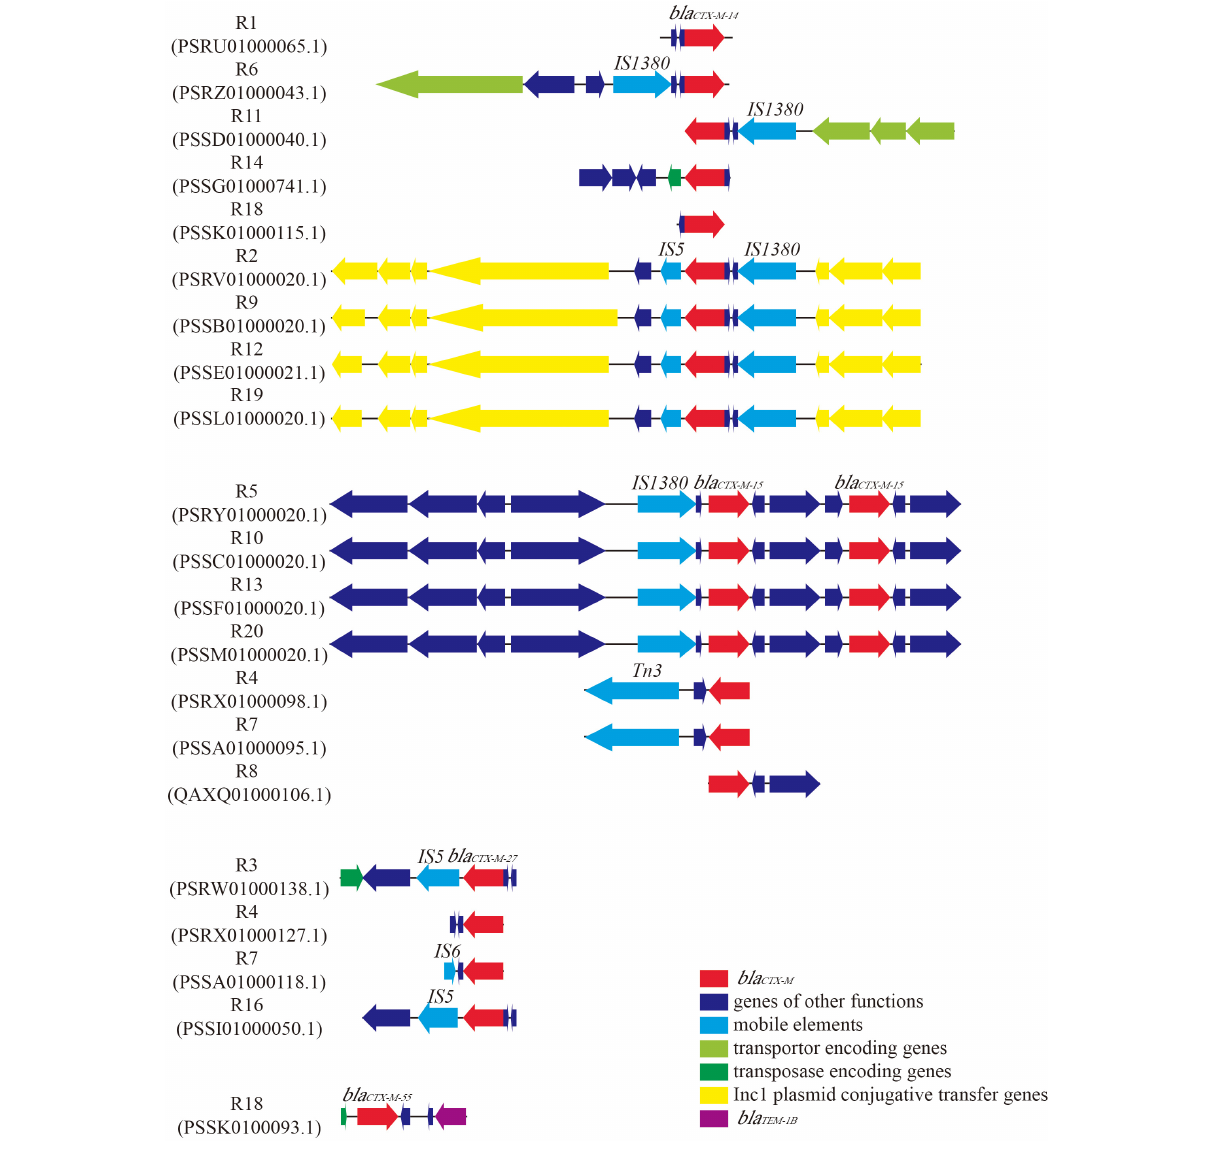
FIGURE 1 | Genetic environment of bla CTX − M in 18 Escherichia coli strains. GenBank accession numbers of the contigs which contain bla CTX − M were given below the strain names. ORFs were represented by arrows. The color of the arrow indicated the function of the gene. Subtypes of bla CTX − M and insertion sequence (IS) were labeled above the